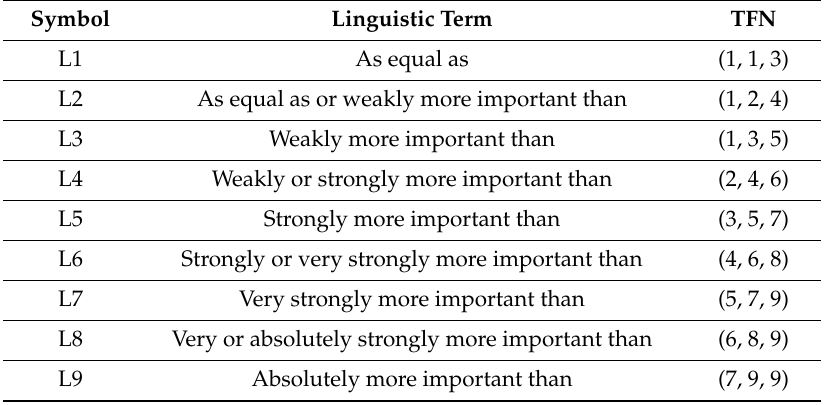
Table 2. Linguistic terms for expressing the relative priorities of critical